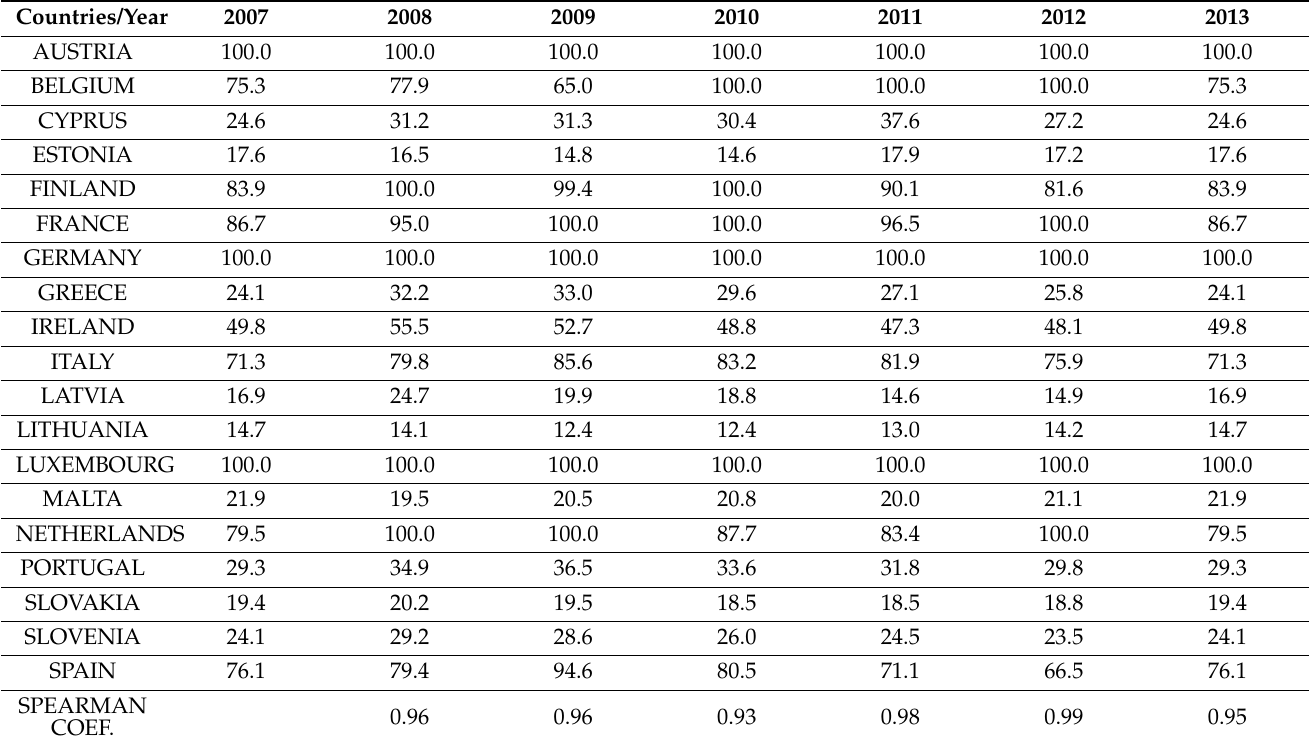
Table 3. Relative efficiency of the Eurozone countries (2007–2013).